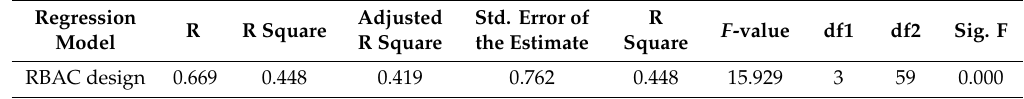
Table 5. Summary of model results.